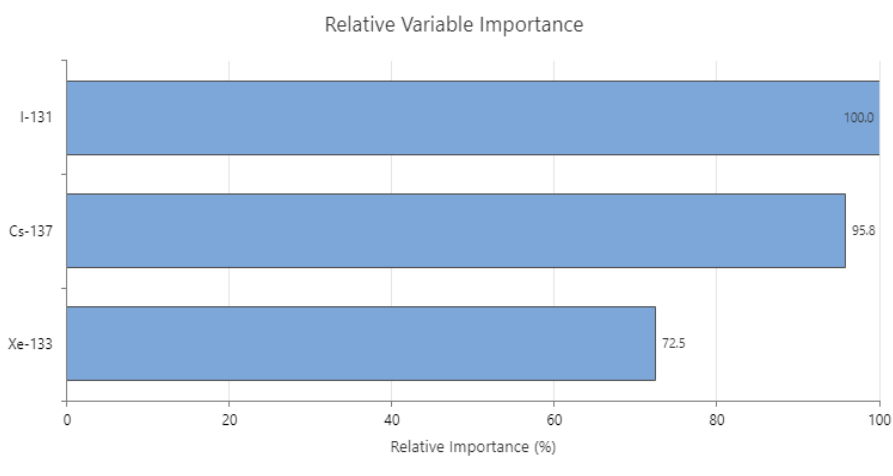
Figure 5. The relative importance of predictors in October (fall) .